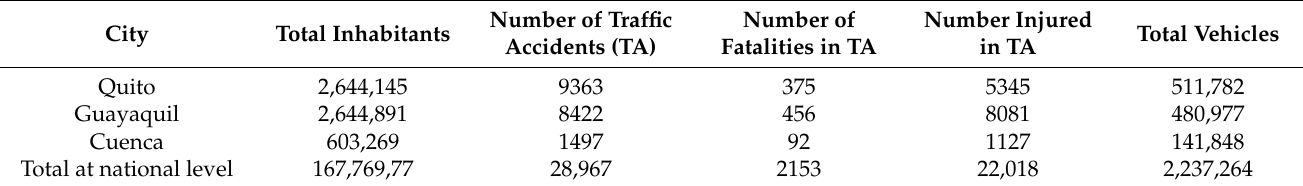
Table 1. Social and accident characteristics in 2017 for the three provinces of Ecuador.